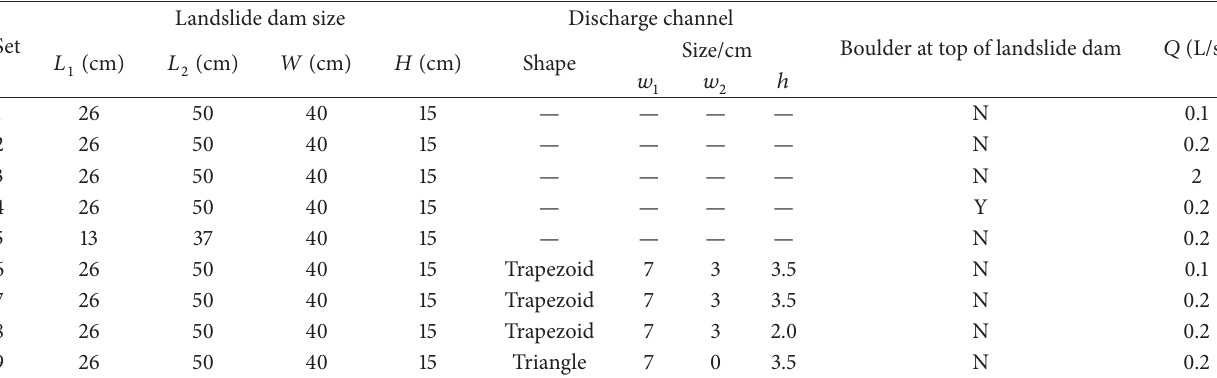
Table 3: Experimental setup for the dam-break analysis of landslide